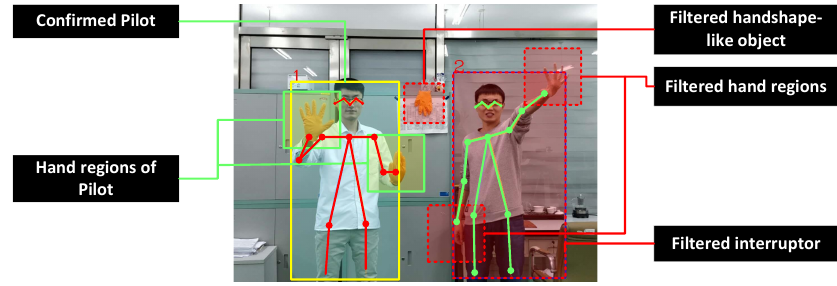
Figure 10. The real UAV pilot and his hands will be correctly extracted and the other human and background noise will be